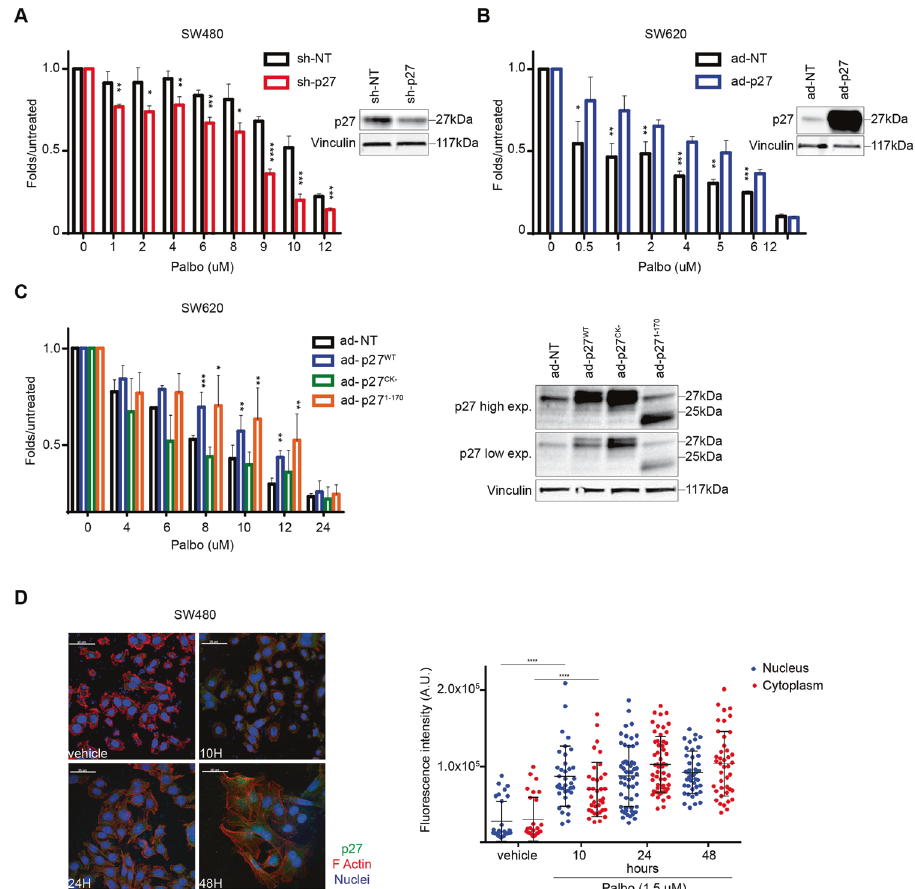
Fig. 2 Expression of p27 modulates sensitivity to Palbo, in vitro. A Left: Dose – response curve of SW480 control (sh-NT) and p27-silenced cells (sh-p27), treated for 72 h with increasing doses of Palbociclib, as indicated. B Left: Dose – response curve of SW620 transduced with adenoviral particles expressing p27 (Ad-p27) or not (Ad-NT), treated for 48 h with increasing doses of Palbo. C Dose – response curve of SW620 cells transduced with control (Ad-NT), p27 WT (Ad-p27 WT ) and p27 mutants (Ad-p27 CK- , Ad-p27 1-170 ) expressing adenoviral particles, treated for 48 h with increasing doses of Palbo, as indicated. In A , B and C on the right are reported the Western Blot analyses evaluating p27 expression in the transduced as indicated cells and used in each dose-response curve. Vinculin was used as loading control. In all dose- response curves, cell viability was measured by MTS assay and data show the percentage of viable treated cells compared to untreated cells in 3 independent experiment. Student ’ s t -test was used for statistical analysis and asterisks indicate signi fi cant differences. * p < 0.05; ** p < 0.01; *** p < 0.001; **** p < 0.0001. D Left: Immuno fl uorescence (IF) analysis of p27 (green), F-Actin (red) and nuclei (To-Pro-3, blue) performed on SW480 parental cells treated with vehicle or Palbociclib 1.5 μ M for the indicated time points (hours, H). Right: quanti fi cation of p27